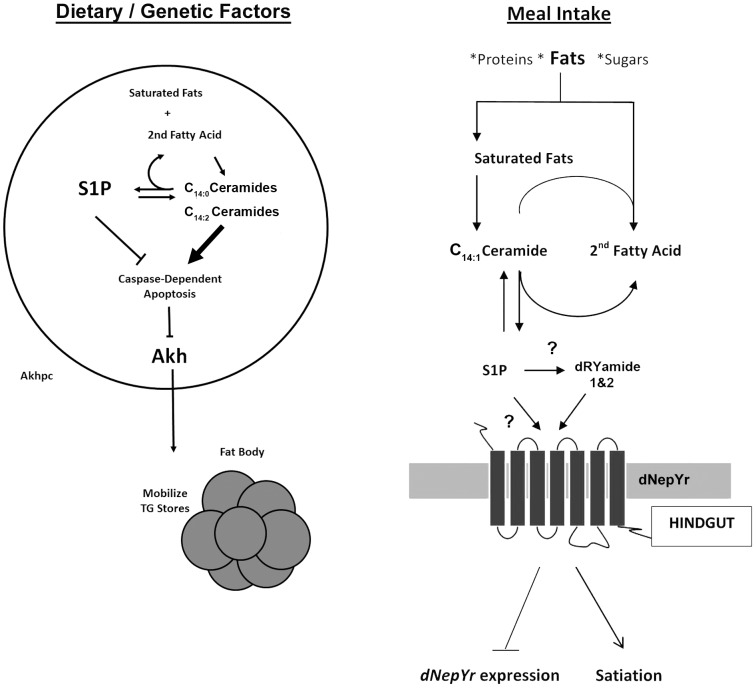
Sphingolipid regulation of caloric intake and fat mobilization.Both saturated and unsaturated fats act as precursor “input” molecules in the production of “output” sphingolipid intermediates, specifically ceramide and S1P, which act to transduce a physiological response. (Left) Sphingolipid metabolism regulates Akh cell viability and function (Right). After a meal, S1P accumulates downstream of elevated ceramide. S1P, either directly or indirectly (through dRYamide), induces dNepY receptor signaling in the hindgut, inducing appetite suppression, reduced caloric intake and downregulation of dNepYr mRNA expression (negative feedback).